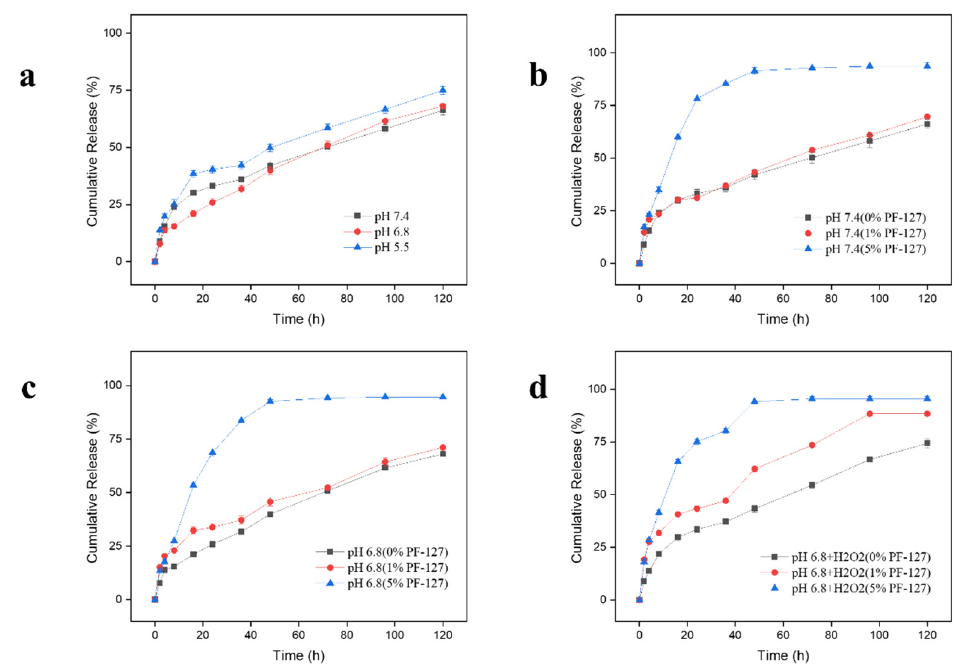
Figure 3. In vitro cumulative release profiles of drugs from undecorated NPs in buffers with ( a ) different pH values. In vitro drug release behaviors of NPs in buffers with pH ( b ) 7.4, ( c ) 6.8, and ( d ) 6.8 values and 10 mM H ₂ O ₂ . Data are expressed as means ± SD ( n = 3).